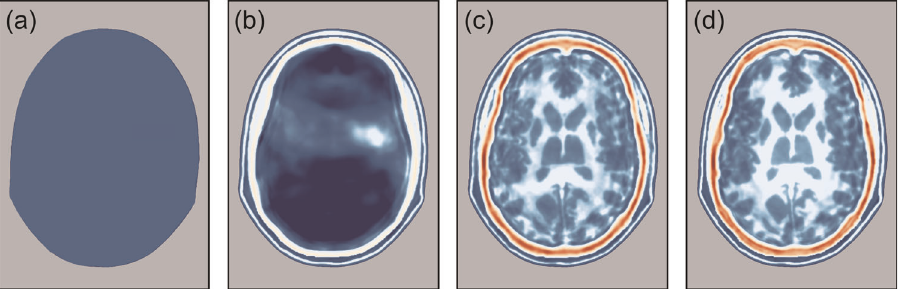
Fig. 4 Inverting from a homogeneous starting model. a Homogeneous starting model with velocity of water. b Model recovered using conventional FWI. c Model recovered using AWI. d Model recovered by FWI following AWI. The colour scale is as shown in Fig. 3. Note that the skull is not present in the starting model, and the fi nal model is well